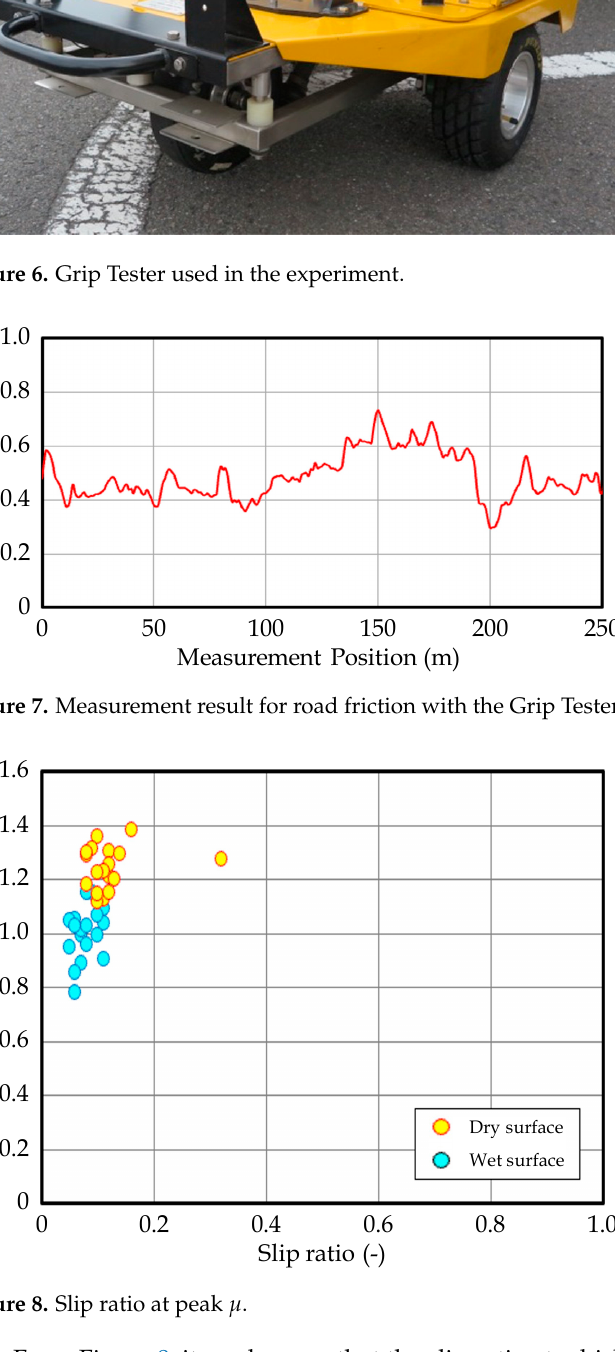
Figure 8. Slip ratio at peak μ .